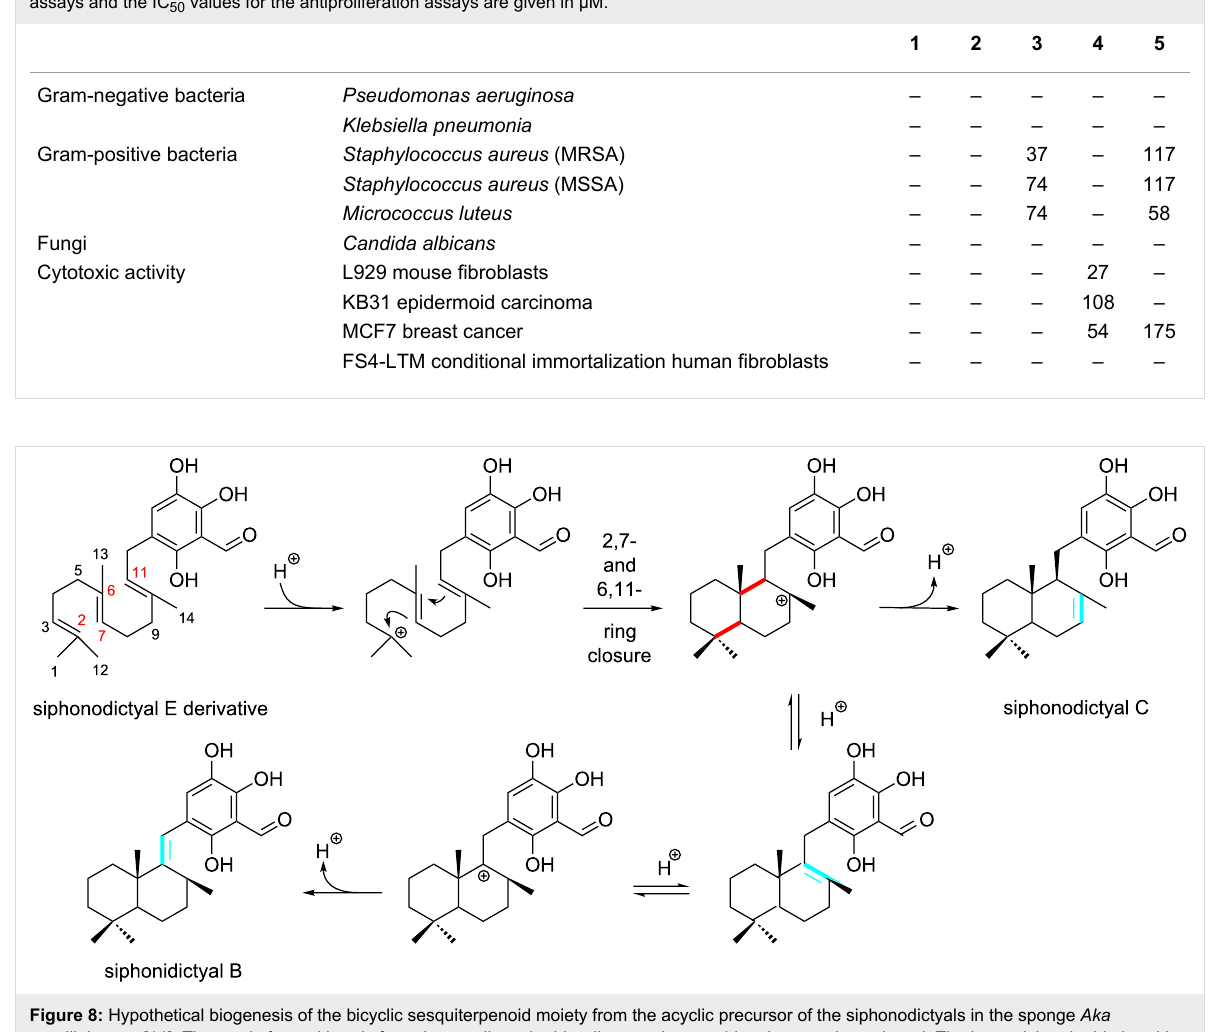
Figure 8: Hypothetical biogenesis of the bicyclic sesquiterpenoid moiety from the acyclic precursor of the siphonodictyals in the sponge Aka coralliphagum [11]. The newly formed bonds from the acyclic to the bicyclic sesquiterpenoid moiety are drawn in red. The isomerizing double bond is drawn in